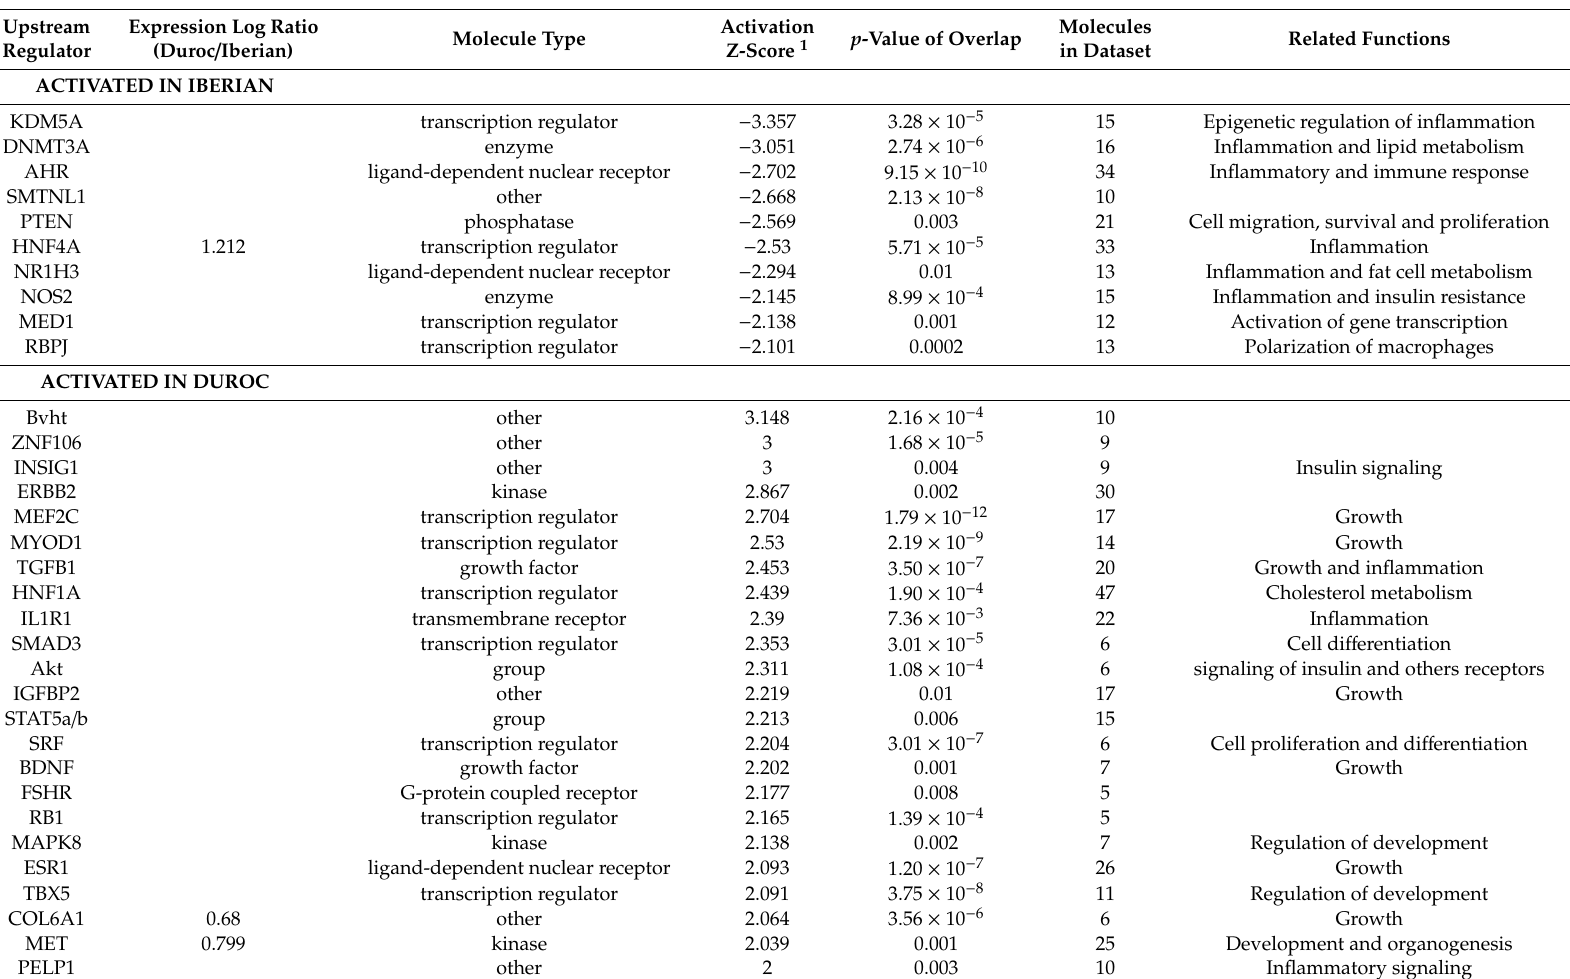
Table 3. IPA-based list of activated upstream regulators (sorted by z-score) in the set of DEGs according to breed ( p -value < 0.01 and z-score > 2 or < − 2). Upstream